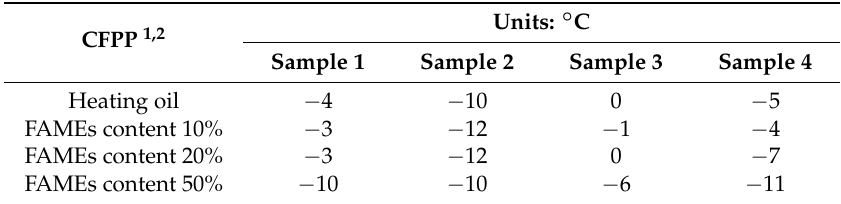
Table 8. Experimental results for cold filter plugging point of heating oil